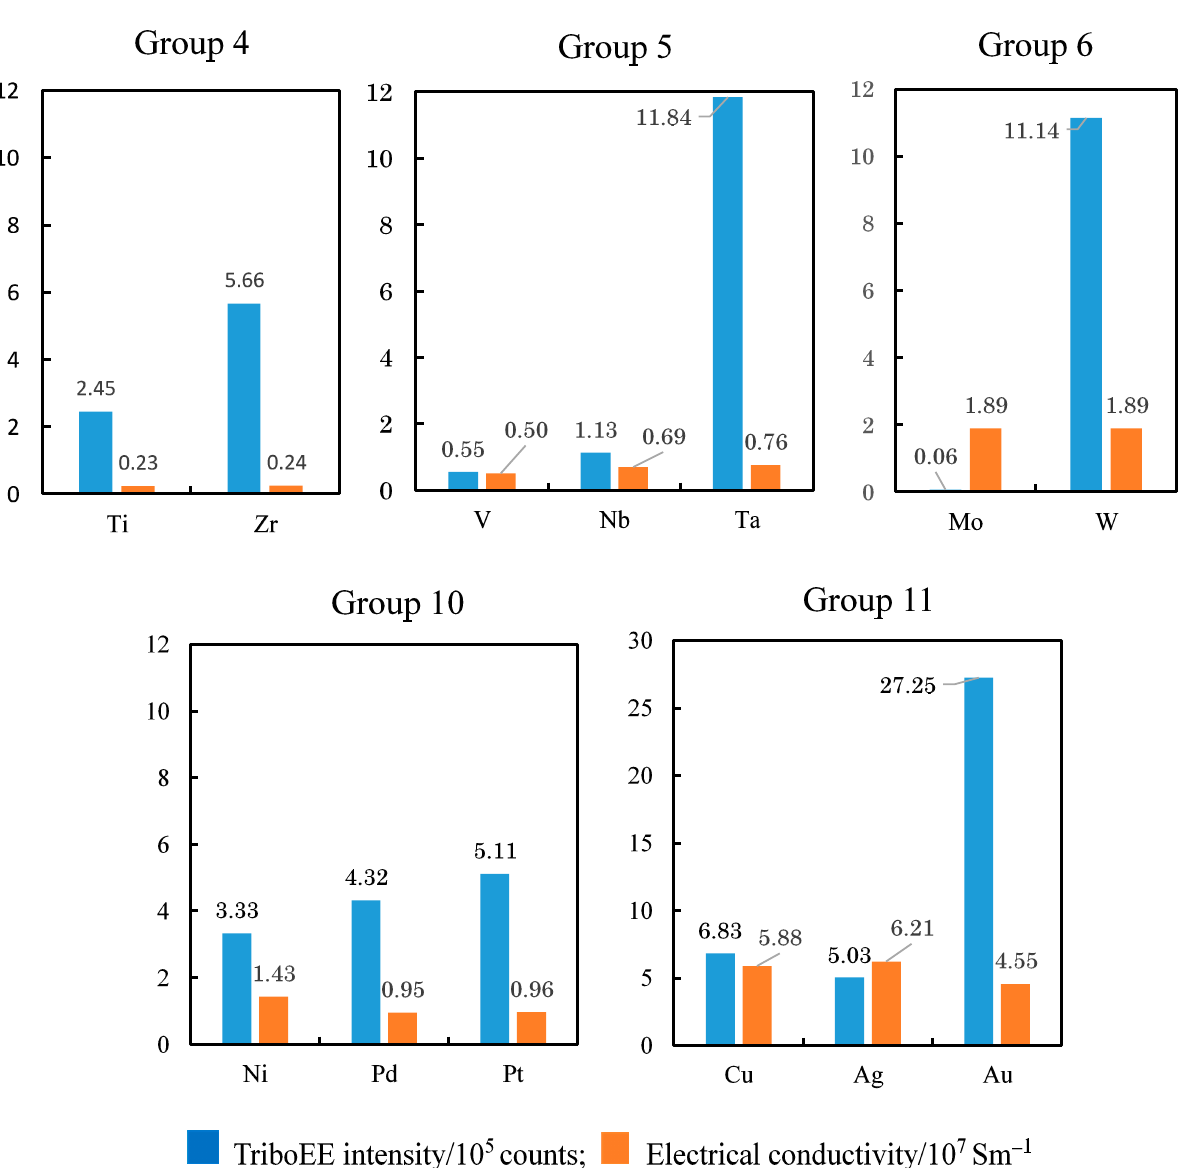
Figure 11. The relationship between TriboEE intensity and electrical conductivity values for metals in groups 4, 5, 6, 10, and 11.